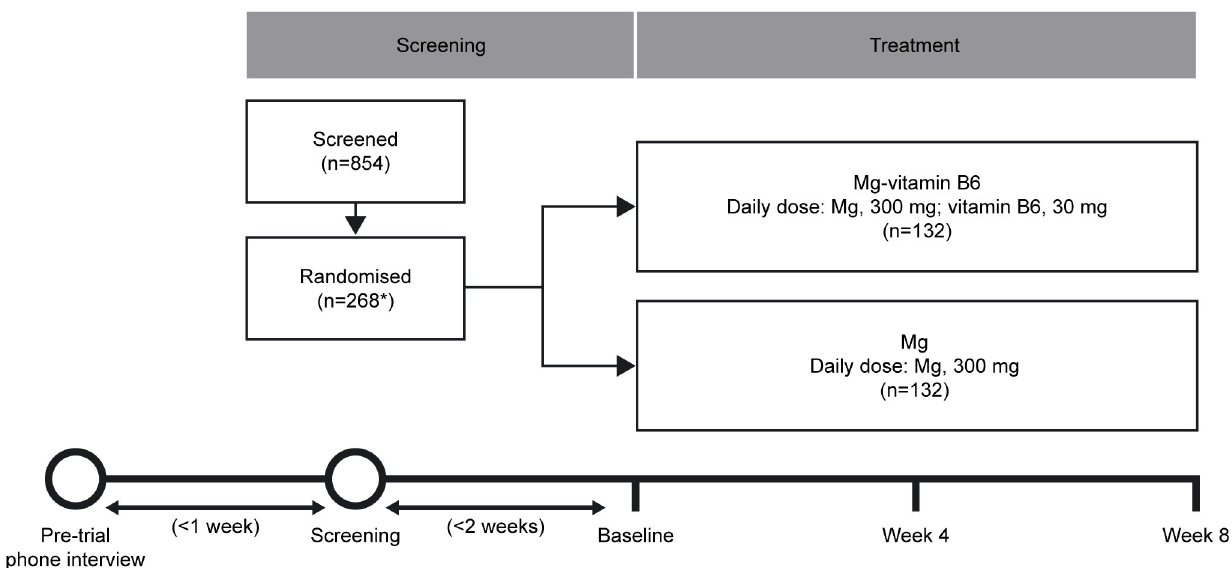
Fig 2. Trial design. � Four subjects did not proceed to the treatment phase and did not receive any investigational product due to major protocol deviations. Mg, magnesium.